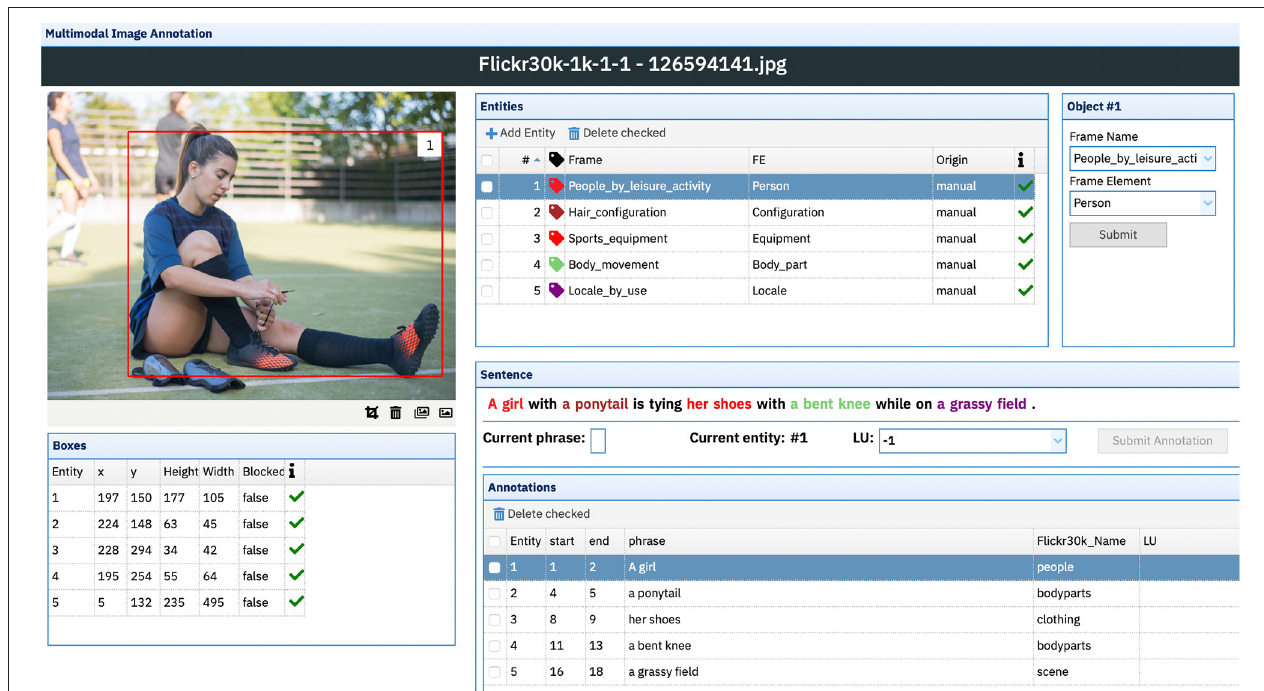
FIGURE 11 | Multimodal image annotation interface. Due to copyright issues, the original image from the Flickr 30K corpus has been substituted by a similar licensed image from Adobe Stock. Image reproduced from Adobe Stock with permission.